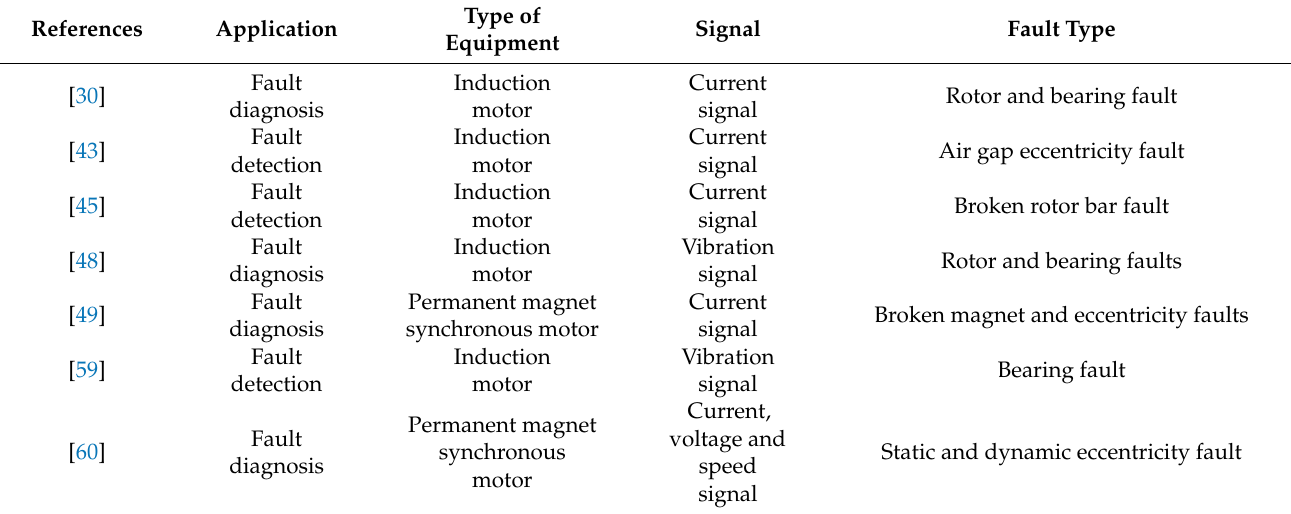
Table 4. Motor condition monitoring using wavelet transform.